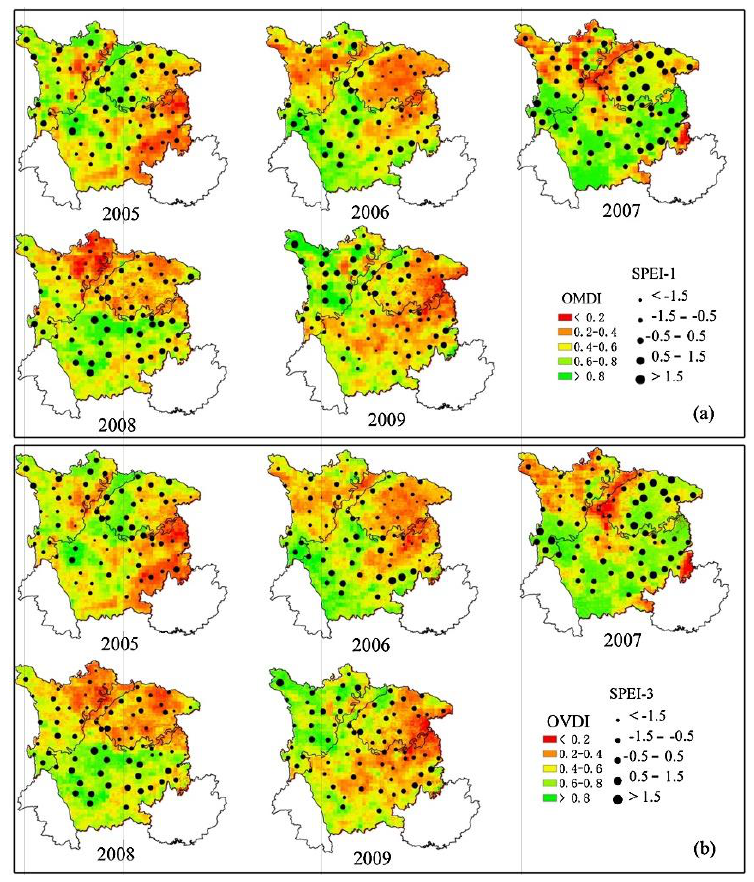
Figure 3. (a) Spatial distribution of drought monitored by OMDI with validations by SPEI-1and SPEI-3 in July between 2005 and 2009; (b) Spatial distribution of drought monitored by OVDI with validations by SPEI-1and SPEI-3 in July between 2005 and 2009 [91]. Table 5. Information extraction of